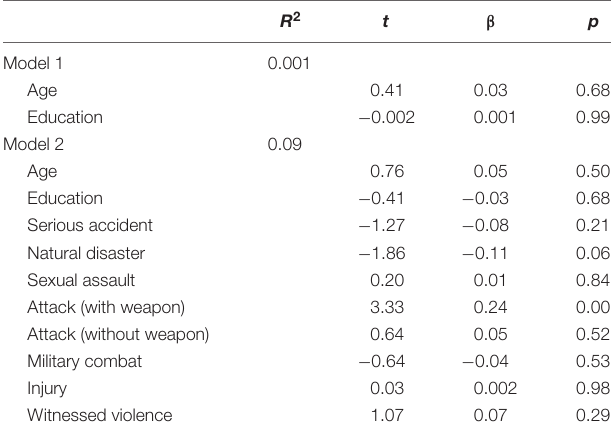
TABLE 3 | Potentially traumatic event type predicting lifetime major depressive episode symptoms in males ( n = 282).